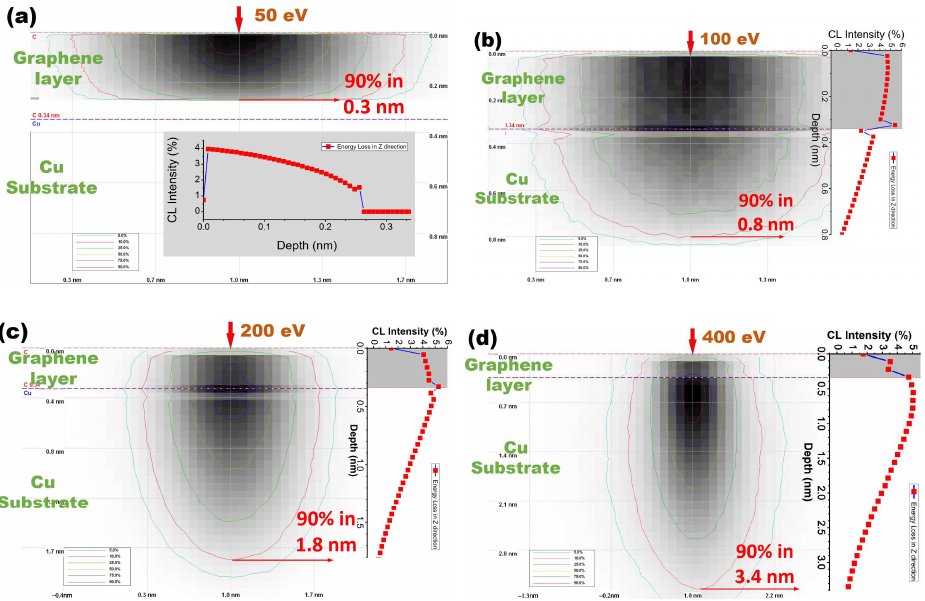
Figure 12. Electron interaction range of GoCu under different energy E-beam irradiation: ( a ) 50 eV; ( b ) 100 eV; ( c ) 200 eV; ( d ) 400 eV.